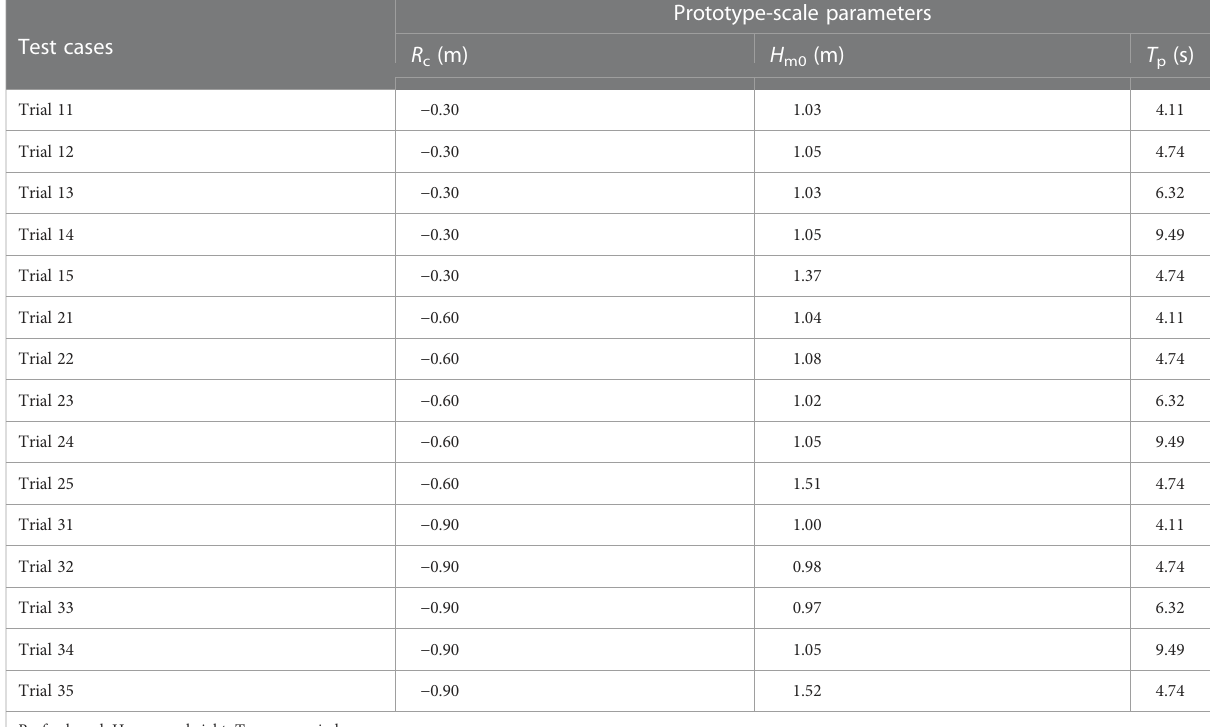
TABLE 1 Test cases of the physical model tests.